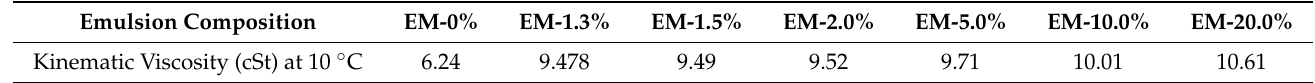
Table 2. The viscosity of different water–emulsion